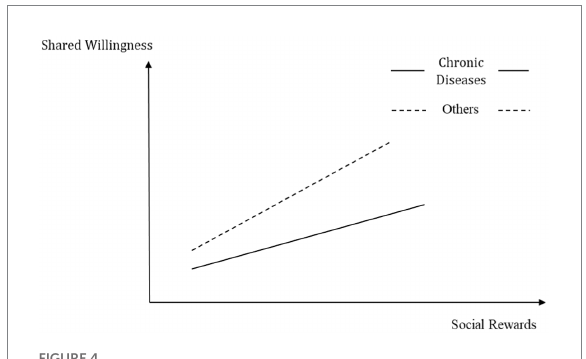
FIGURE 4 Schematic diagram of the regulatory effect of chronic